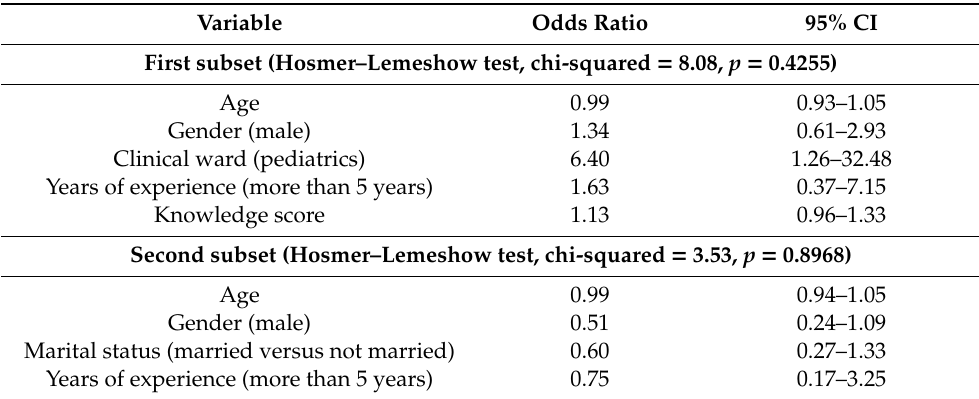
Table 5. Logistic regression analysis, shedding light on the determinants of the score of the third part (“attitudes towards recommending anti-HPV vaccination”) for the first and second subsets of items,